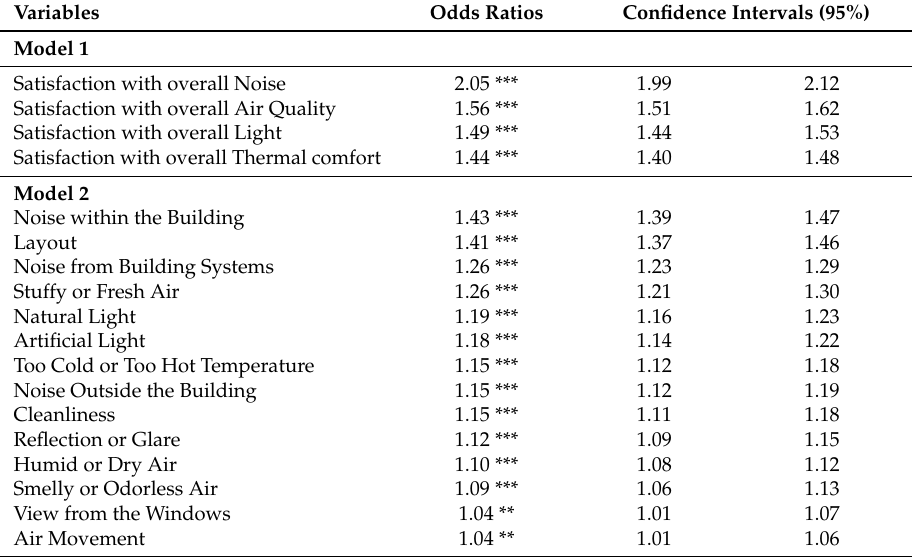
Table 4. Association between overall comfort and satisfaction with indoor environmental quality (IEQ) (Model 1) and detailed indoor environmental parameters (Model 2) in OFFICAIR